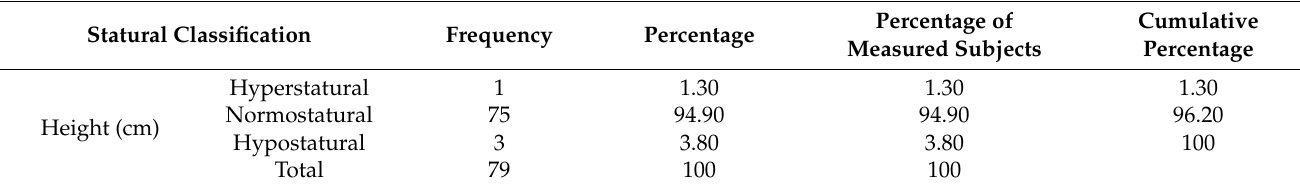
Table 8. Distribution of height in the target group–final testing.